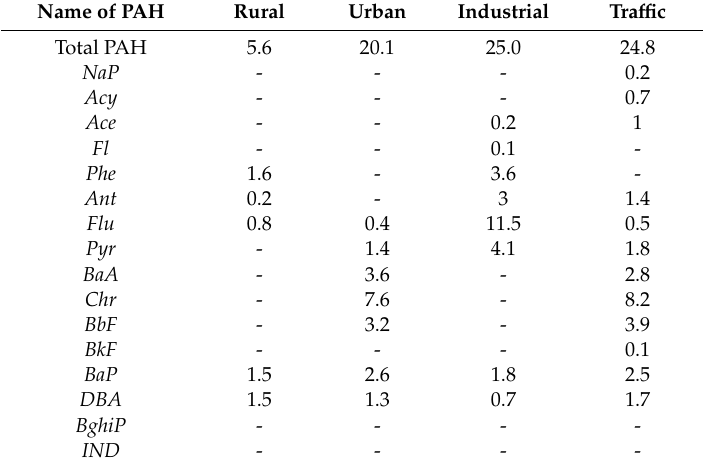
Table 5. Concentration of polycyclic aromatic hydrocarbons (PAHs) (ng / m 3 of air) in PM 2.5 samples. Name of PAH